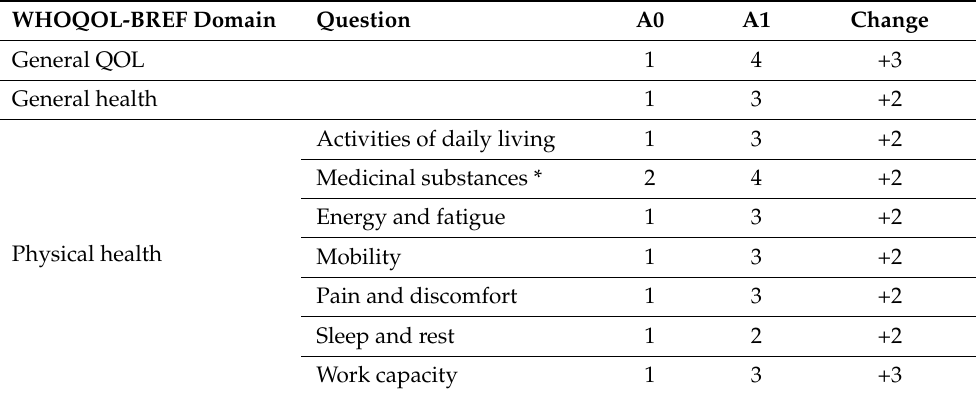
Table 4. Quality-of-life assessment using the WHOQOL-BREF scale before and after rehabilitation. WHOQOL-BREF